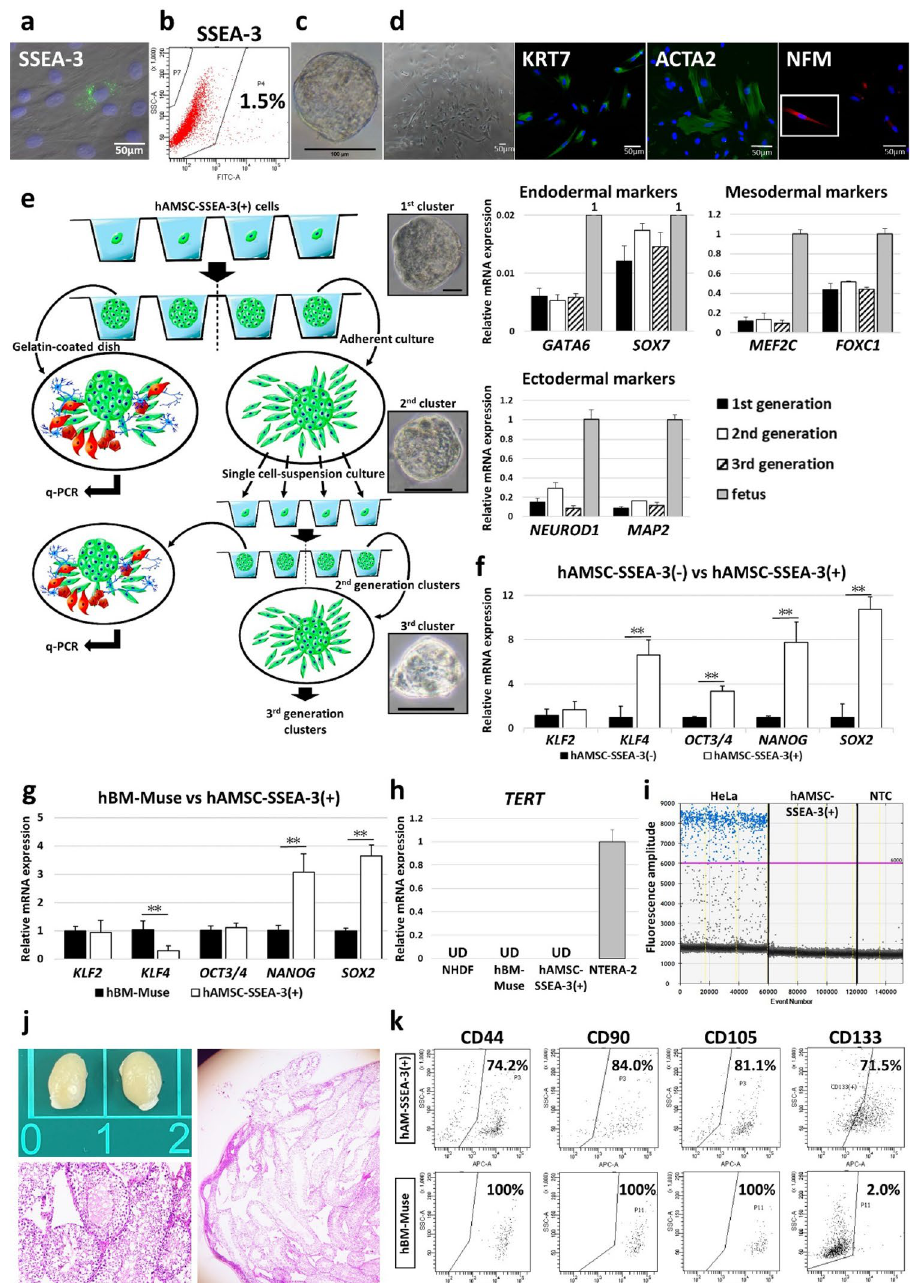
Figure 1. Characterization of SSEA-3(+) cells from human AMSCs. ( a ) Immunocytochemistry for SSEA-3 in hAMSCs (bar = 50 μm). ( b ) Example of SSEA-3(+) cells in hAMSCs in cell sorting. ( c ) Clusters were formed in single-cell suspension culture from hAMSC-SSEA-3(+) cells (bar = 100 µm). ( d ) Phase contrast image of cells expanded from the cluster in a gelatin- coated adherent culture dish and immunocytochemistry for KRT7, ACTA2, and NFM in the expanded cells (bars = 50 μm). ( e ) hAMSC-SSEA-3(+) cells demonstrated a capacity for self-renewal. Schematic diagram outlines experiments that validated self-renewal ability of hAMSC-SSEA-3(+) cells. GATA6 and SOX7 (endodermal), MEF2C and FOXC1 (mesodermal), and NEUROD1 and MAP2 (ectodermal) gene expression was detected in qPCR from cells expanded from each of the clusters from the first to third generations (bars = 50 µm). ( f ) Expression of pluripotency-related genes in hAMSC-SSEA-3(−) and hAMSC- SSEA-3(+) cells (normalized by beta-actin ( ACTB )). Values of hAMSC-SSEA-3(−) cells were set as 1. * p < 0.05; ** p < 0.01. ( g ) Expression of pluripotency-related genes in hBM-Muse and hAMSC-SSEA-3(+) cells (normalized by ACTB ). Values of hBM-Muse cells were set as 1. * p < 0.05; ** p < 0.01. ( h ) Expression of TERT in normal human dermal fibroblasts (NHDF), hBM-Muse cells, hAMSC-SSEA-3(+) cells, and NTERA-2 measured by qPCR (normalized by ACTB ). Values of NTERA-2 were set as 1. UD = under limits of detection. ( i ) Number of telomerase products in HeLa cells, hAMSC-SSEA-3(+) cells and non-template control (NTC) measured by ddPCR. Each dot on the ddPCR output represents a unique droplet that is either positive or negative for a fluorescent signal whose threshold was 6000. ( j ) Transplantation of hAMSC-SSEA-3(+) cells into SCID mouse testis did not form teratoma after 4 months (bar = 100 µm). ( k ) Expression of mesenchymal markers (CD44, CD90, and CD105) and CD133 in hAMSC-SSEA-3(+) and hBM-Muse